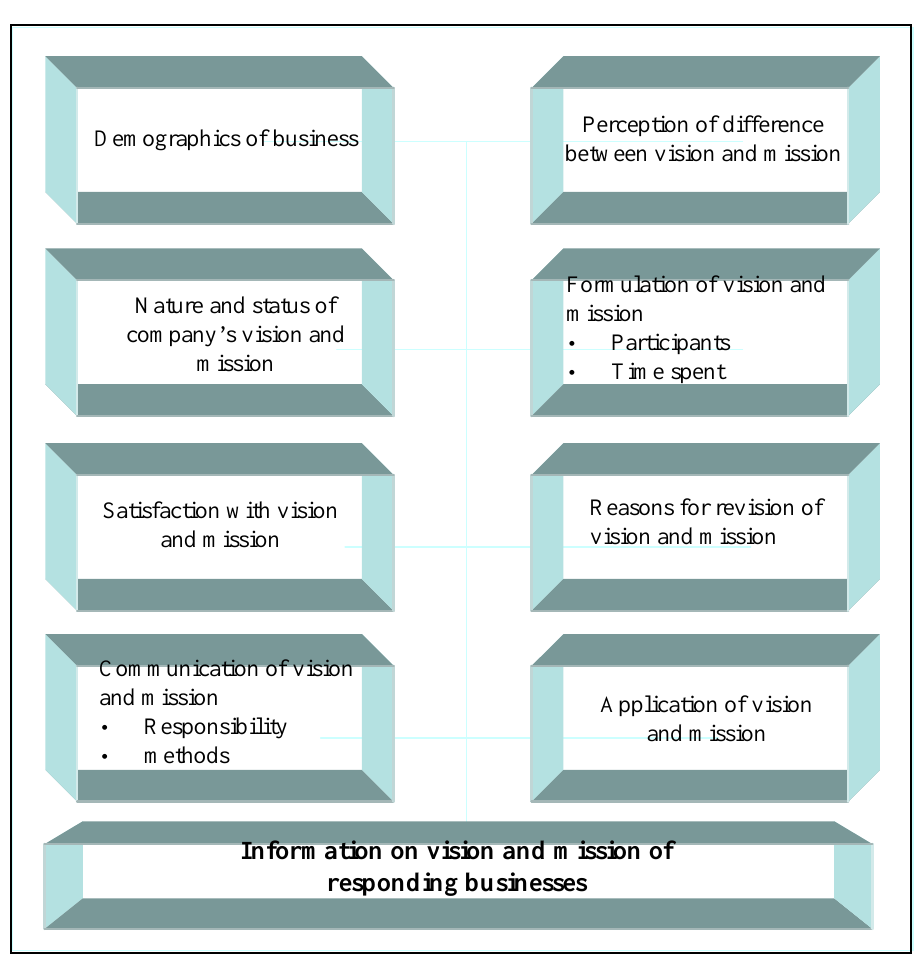
Research framework